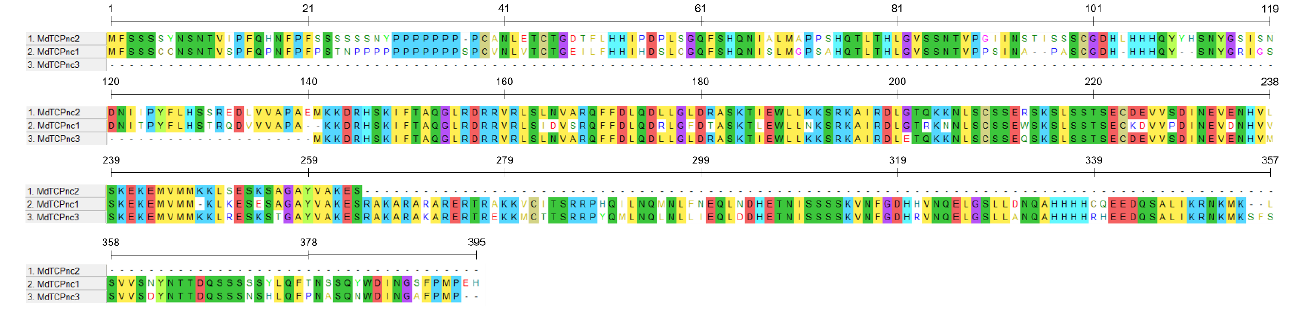
Figure 1. Alignment of the deduced amino acid sequences of the three novel putative MdTCPs , provisionally named MdTCPnc1 / 2 / 3 . Numbers indicate the alignment positions, including gaps. The alignment was performed and visualized on MEGA X software. A colored background (MEGA X default color code) indicates identical positions in at least two sequences.